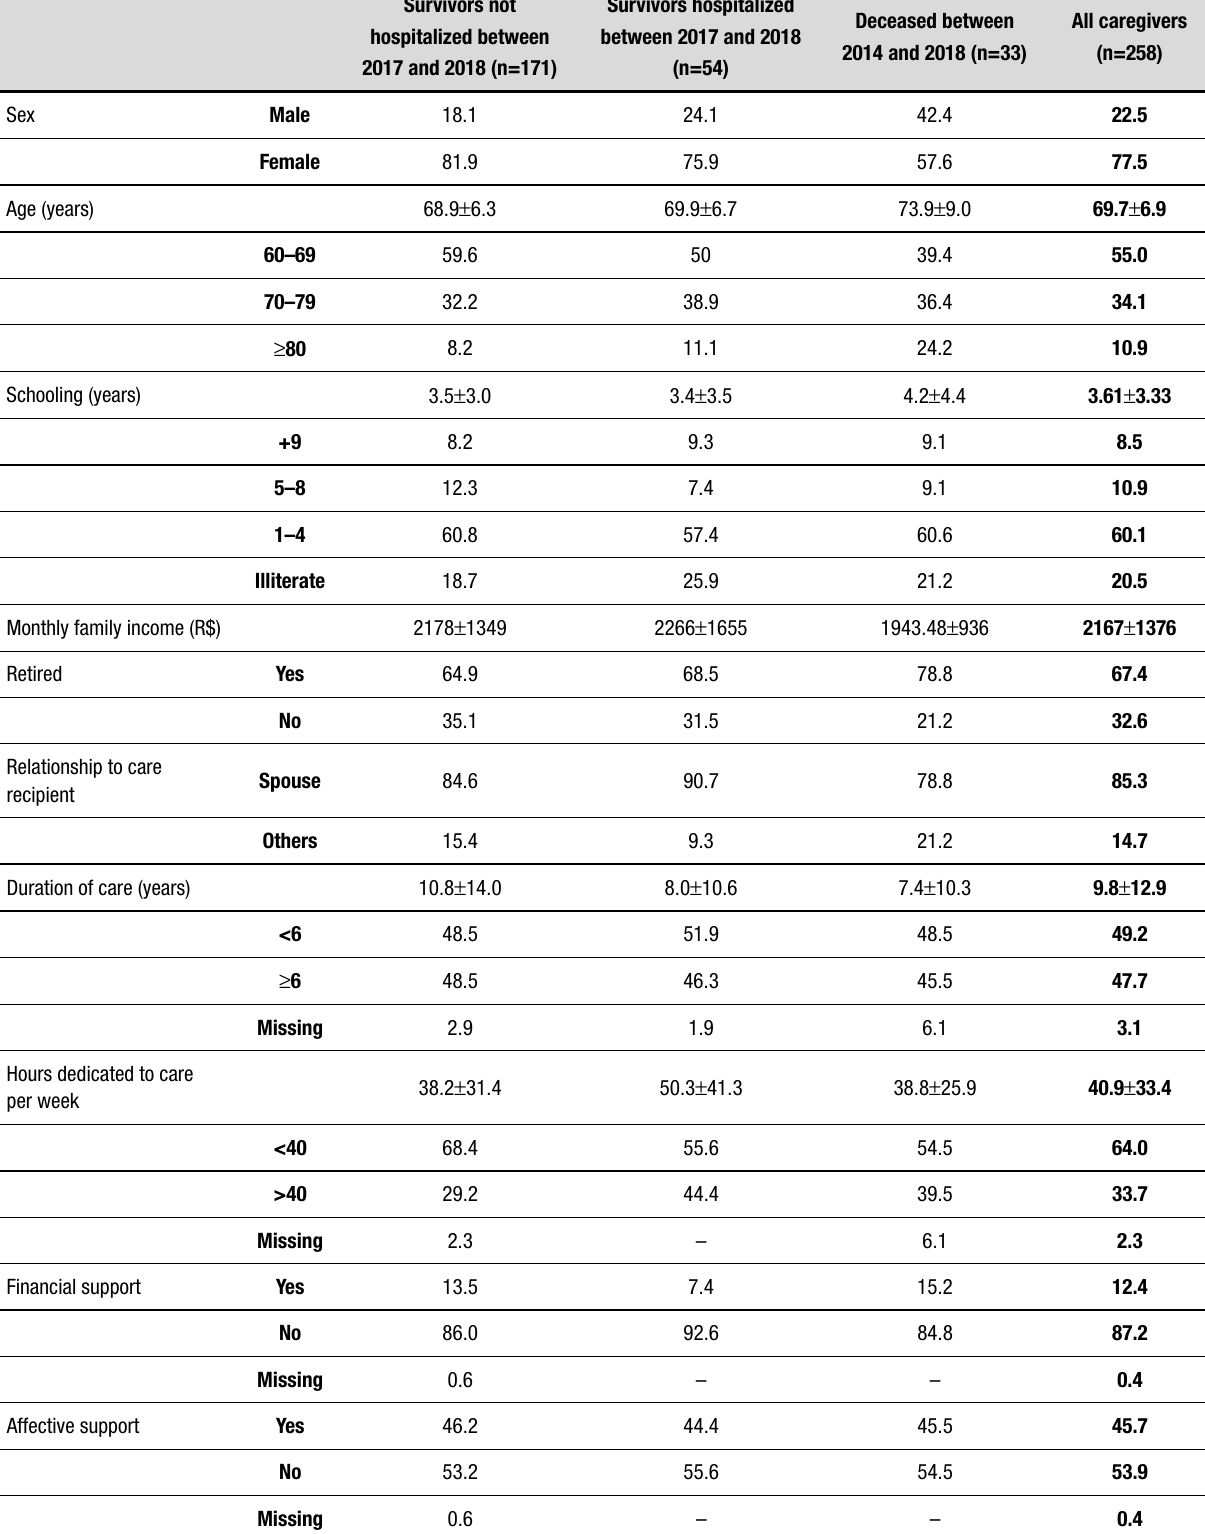
Table 1. Baseline, demographic, and care-related characteristics of caregivers. São Carlos, Brazil,